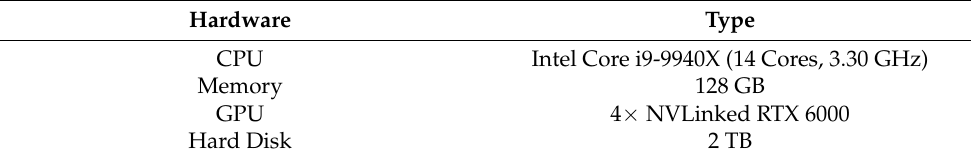
Figure 2. Muzzle detection and extraction procedure based on YOLOv3. Table 1. Lambda Quad RTX 6000 hardware details.